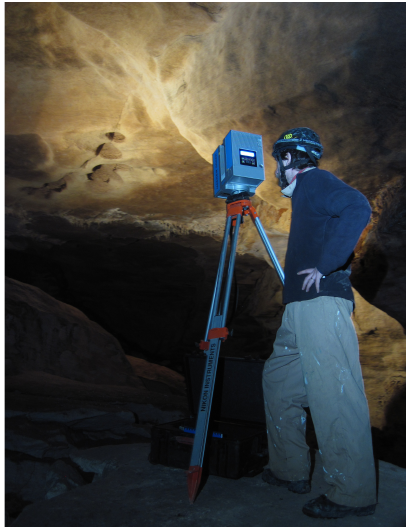
Figure 2. An image of the laser scanner while